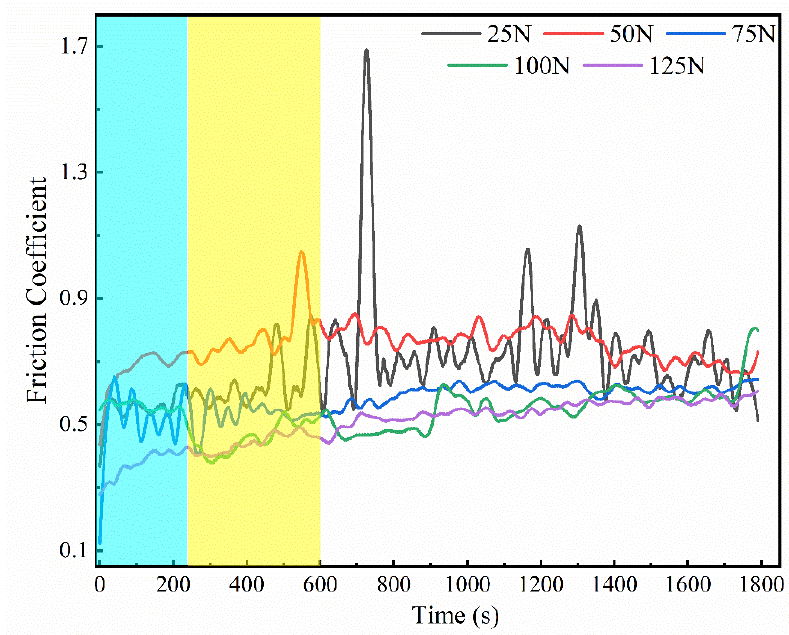
Figure 9. The curve of the friction coefficient of sample YG8-10 over time under various loads.